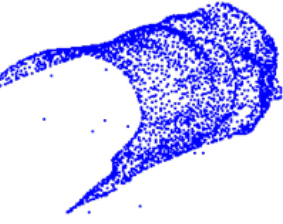
Figure 15. Point cloud with some points being replaced with Gaussian noise.